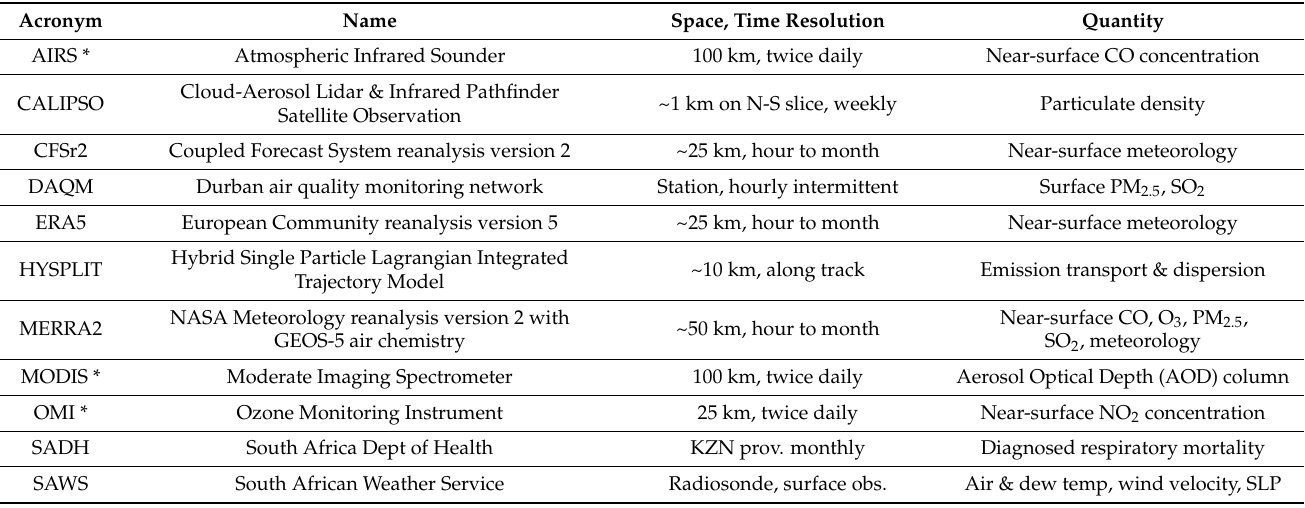
Table 1. Datasets used in the analysis